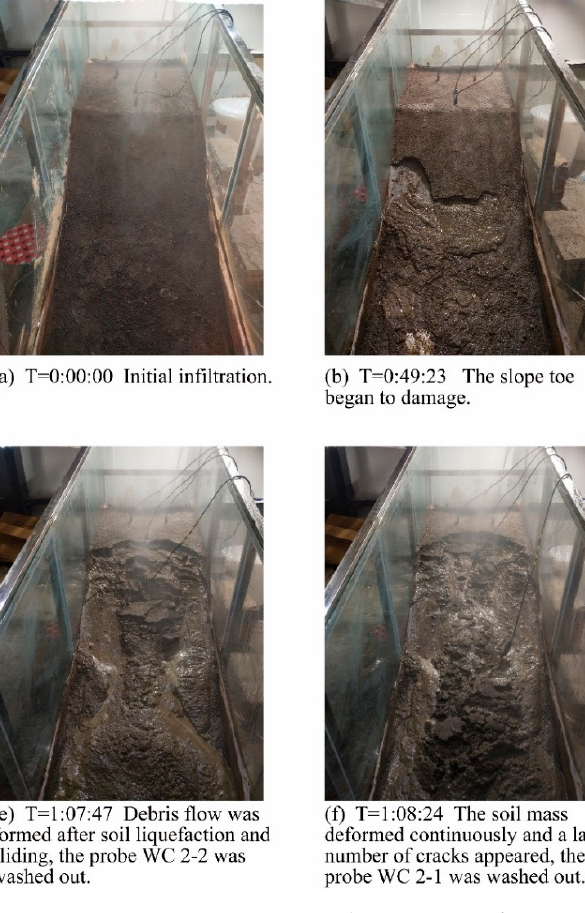
Figure 14. Damage characteristics of STHG condition under extraordinary rainstorm (77.65 mm/h). Figure 13. Damage characteristics of STHG condition under extraordinary rainstorm (77.65